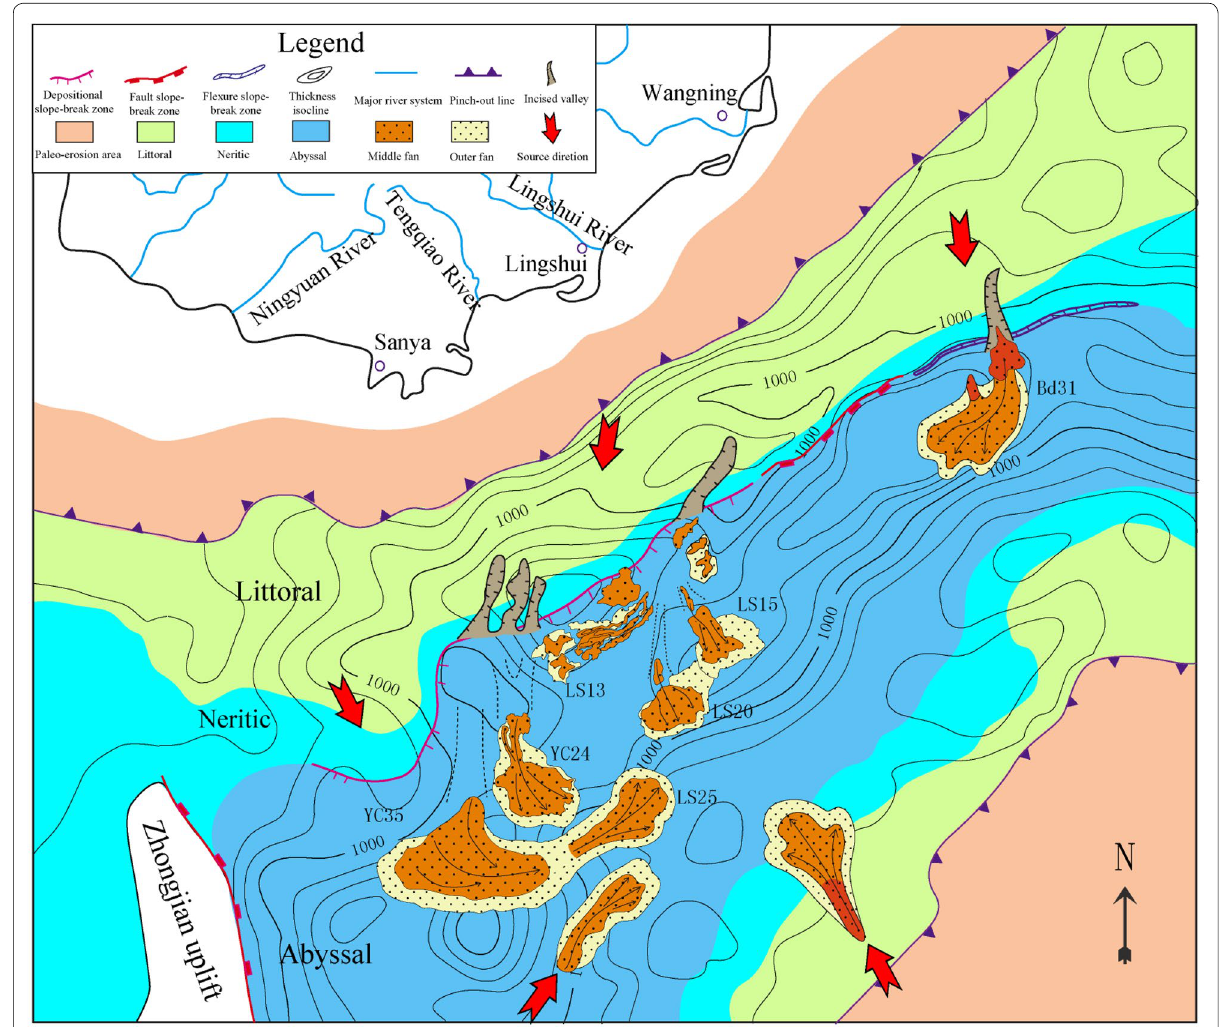
Fig. 4 Sedimentary facies of the Meishan Formation in the Ledong and Lingshui sags, Qiongdongnan